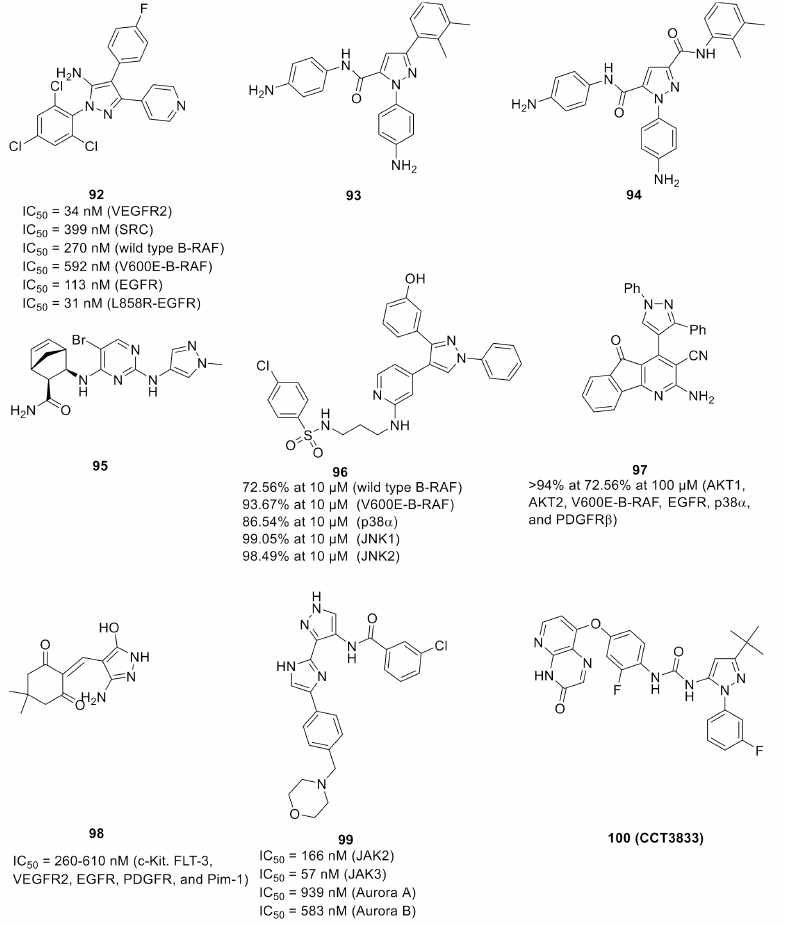
Figure 96. Structures of pyrazole-based multi-kinase inhibitors and their IC 50 values or percen- tage inhibition.